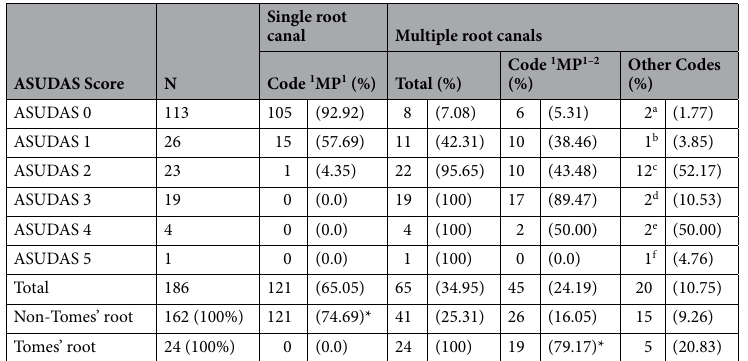
Table 4. Relation between the radicular groove categorized using the ASUDAS scoring and the root canal system morphology scored using Ahmed’s criteria. a One tooth with code 1 MP 1–2–1 and one tooth with code 1 MP 1–3 . b One tooth with code 1 MP 1–3 . c Eight teeth with code 1 MP 1–2–1 and four teeth with code 1 MP 1–2–1–2 . d One tooth with code 1 MP 1–2–1 and one tooth with code 1 MP 1–3–2–1 . e Two teeth with code 1 MP 1–3 . f One tooth with code 2 MP 1 M 1 DB 1 DL 1 . * P <